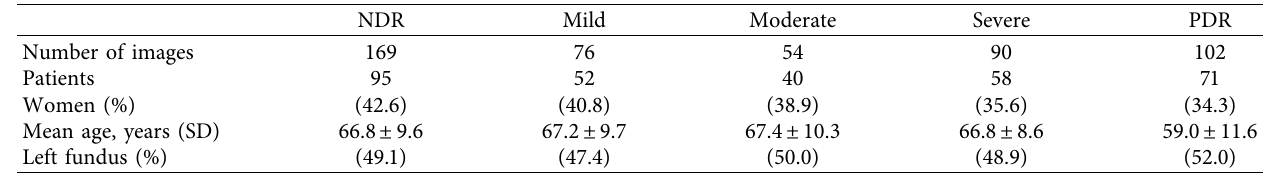
Table 1: Patients’